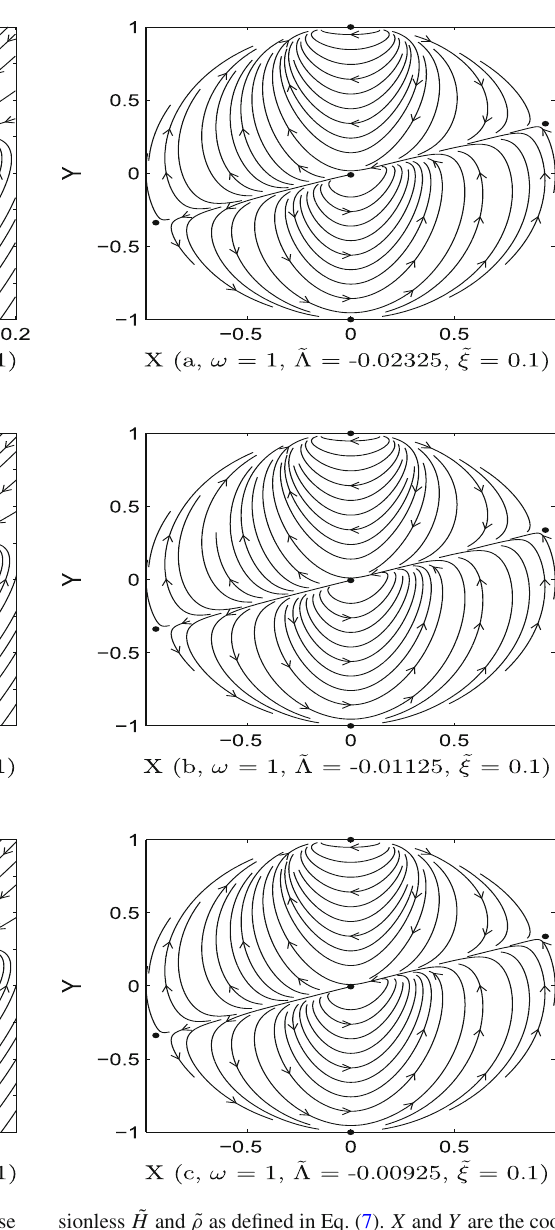
Fig. 13 Uncompact (left panel) and compact (right panel) phase sionless ˜ H and ˜ ρ as defined in Eq. (7). X and Y are the coordinates on portraits when viscosity is included, ˜ ξ = 0 . 1. Representa- the Poincaré sphere as defined in Eq. (47). The dotted circles represent (cid:11) (cid:12) (cid:11) (cid:12) fixed ω = 1 , ˜ (cid:4) = − 0 . 02325 ω = 1 , ˜ (cid:4) = − 0 . 01125 tive cases are , (cid:11) (cid:12) ω = 1 , ˜ (cid:4) = − 0 . 00925 and . x 1 and x 2 respectively denote the dimen-